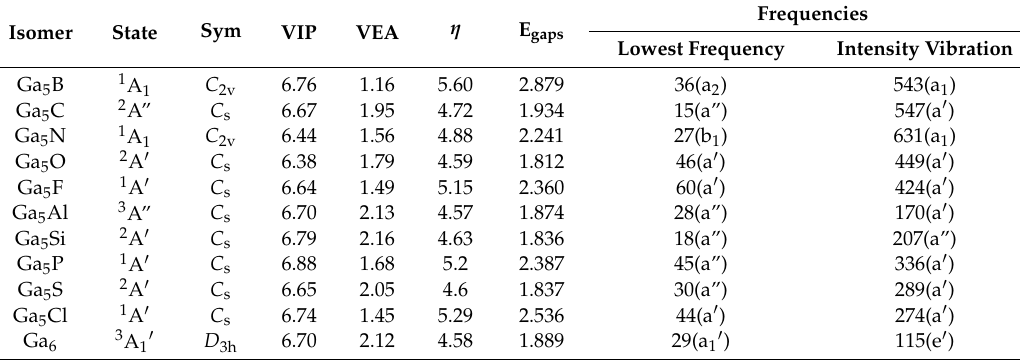
Table 1. State, symmetry, vertical ionization potential (VIP) (eV), vertical electron affinity (VEA) (eV), η (eV) , E gaps (eV), and harmonic vibrational frequencies (cm − 1 ) of Ga 5 X (X = B, C, N, O, F, Al, Si, P, S, Cl and Ga)